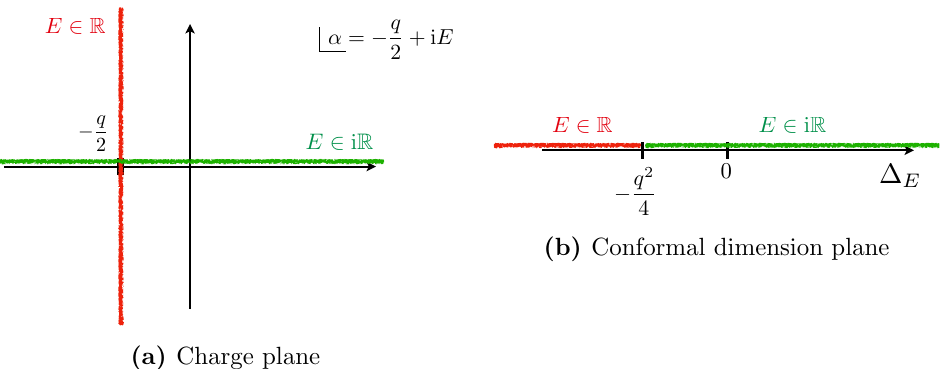
Figure 2. Two branches of the timelike Liouville charge (cid:11) and the corresponding conformal dimensions (cid:1) E . Because of the re(cid:13)ection, the ranges are halved to E The expression for the conformal dimensions (3.14) is now invariant under (cid:11) or equivalently under E E . By the same reasoning as in the spacelike case, V (cid:11) ! (cid:0)